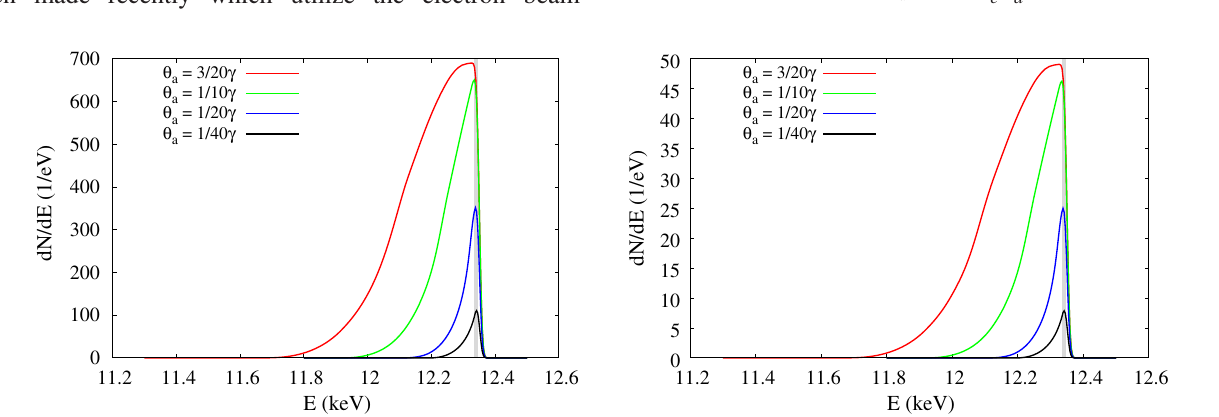
FIG. 14. Number spectra for different apertures generated using 4 000 particles for a 3 . 2 μ m laser spot size (left) and a 12 μ m laser spot size (right). Grey box indicates 0.1% bandwidth. Suggested apertures for brilliance calculation